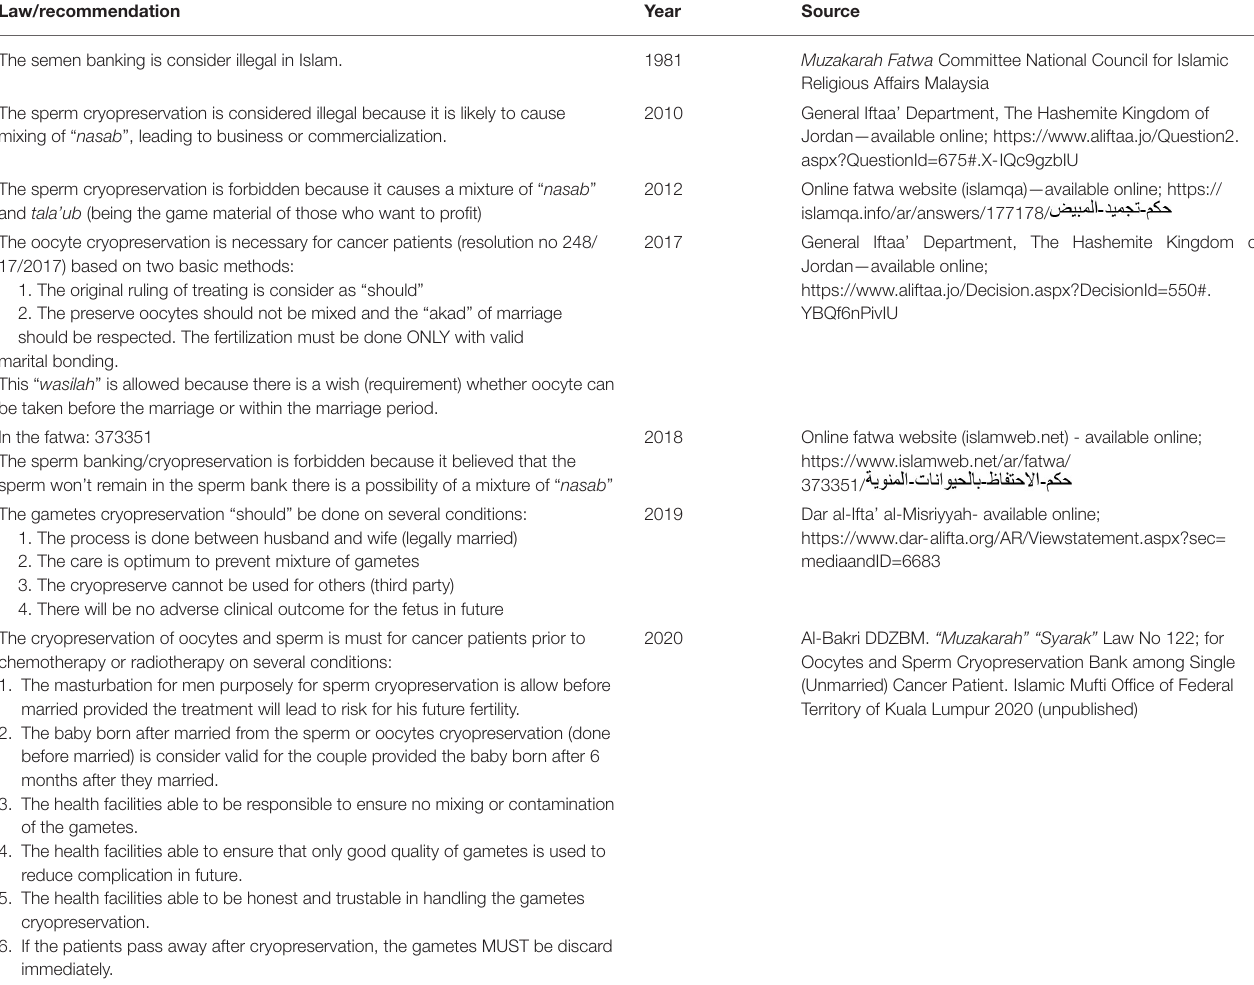
TABLE 1 | The summary of law/recommendation chronologically from Islamic religious bodies.